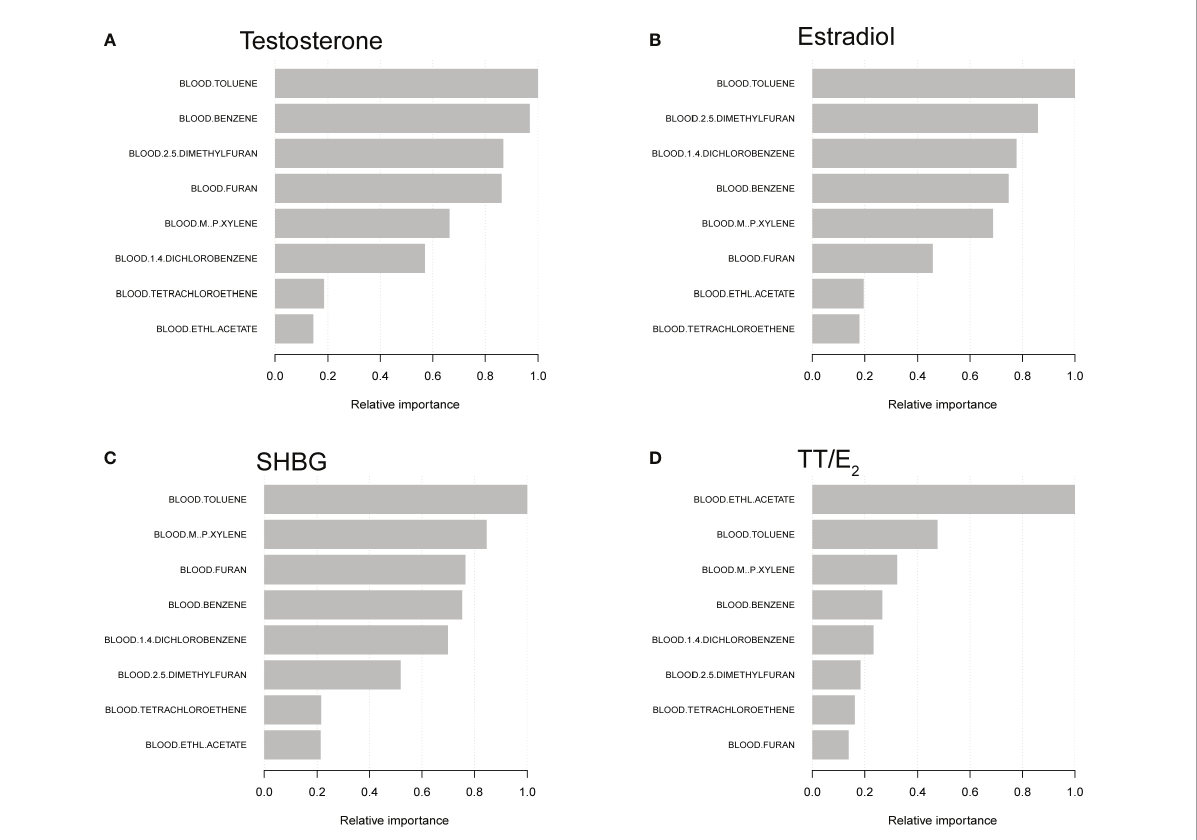
FIGURE 3 XGBoost models indicate the relative importance of speci fi c blood VOCs on sex hormones and the corresponding variable importance score. (A) The relationship between testosterone and VOCs. (B) The relationship between estradiol and VOCs. (C) The relationship between SHBG and VOCs. (D) The relationship between the TT/E 2 and VOCs. The X-axis indicates the importance score, the relative number of a variable used to distribute the data; the Y-axis shows the speci fi c blood